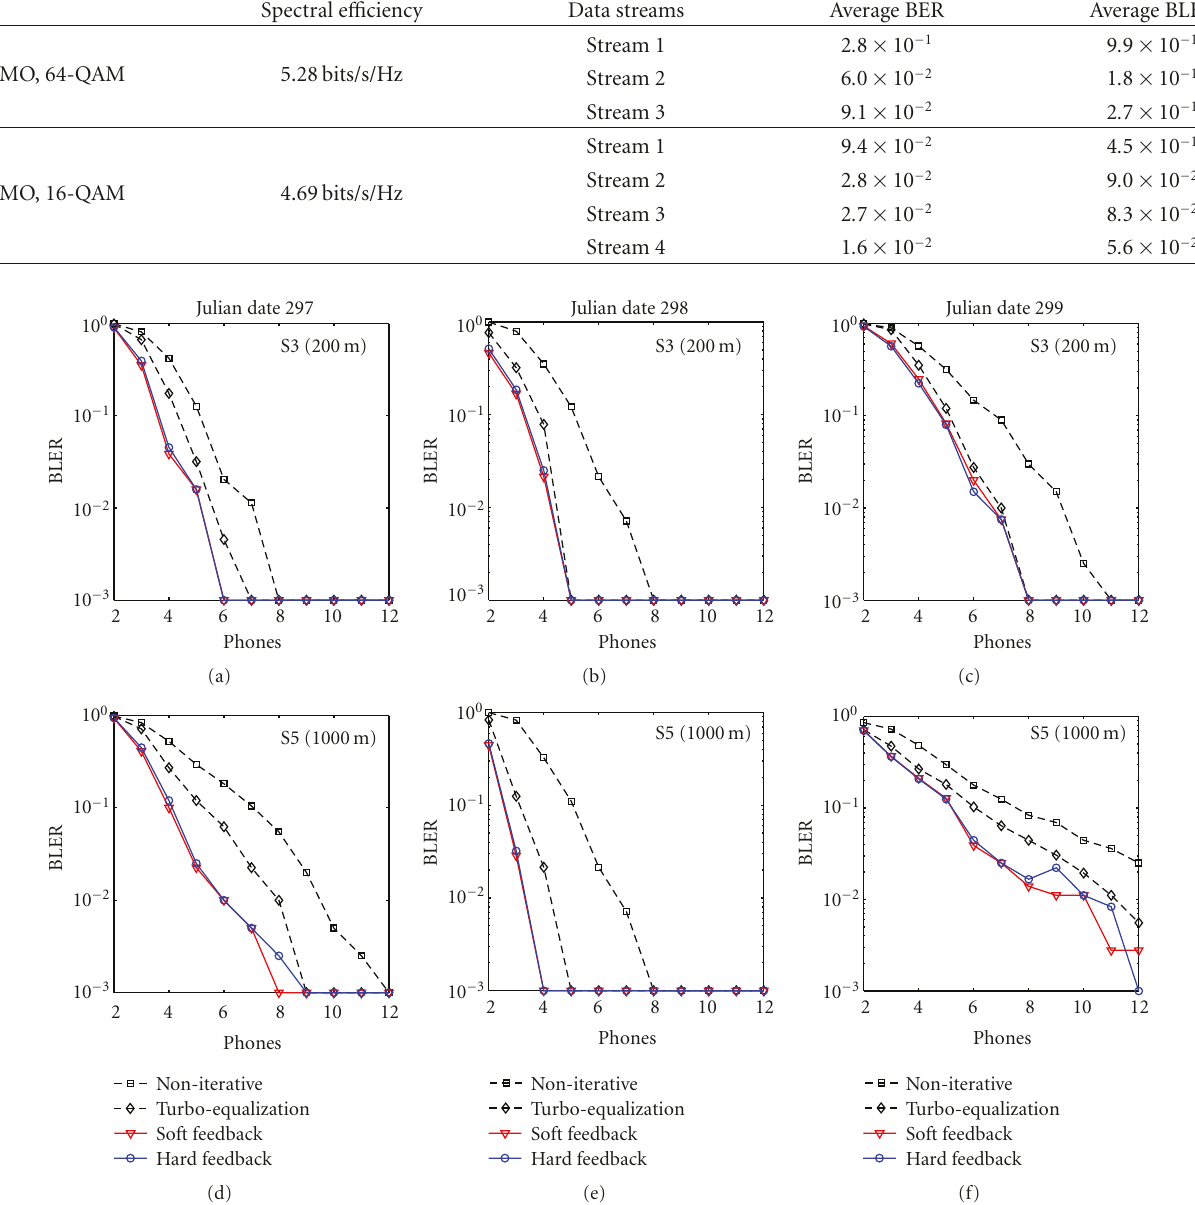
Table 1: Performance results with high data rates from RACE08; twelve receivers used.